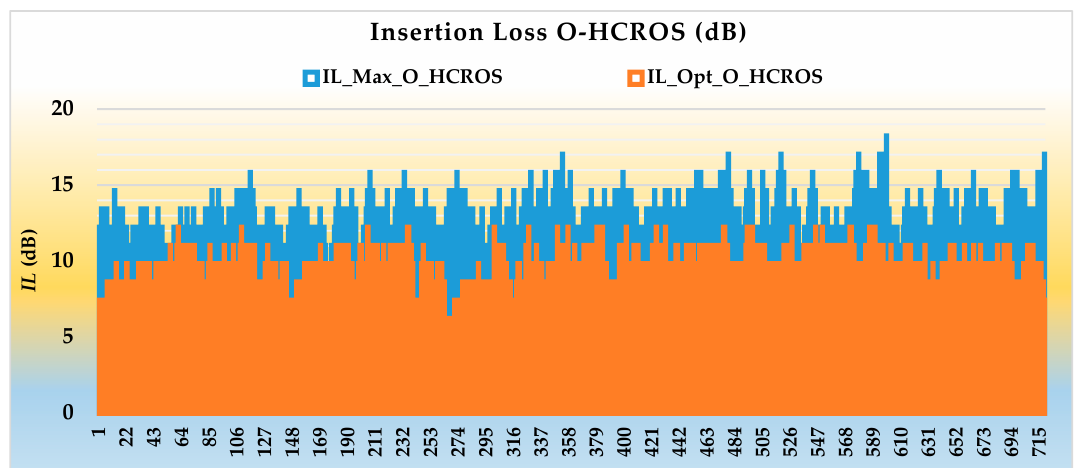
Figure 19. Insertion Loss IL Max_O_HCROS and IL Opt_O_HCROS for all 720 I/O links in optimized HCROS.